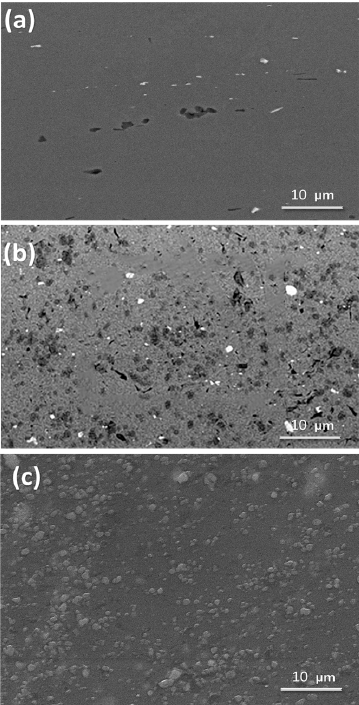
Figure 4. SEM images: ( a ) monocomposite AA7075/GNPs, ( b ) hybrid composite AA7075/GNP+BN, ( c ) hybrid composite AA7075/GNP+BN+VC.